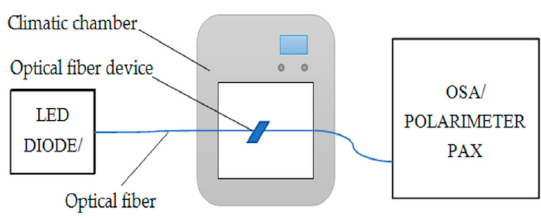
Figure 6. Setup for measurement of optical fiber devices.